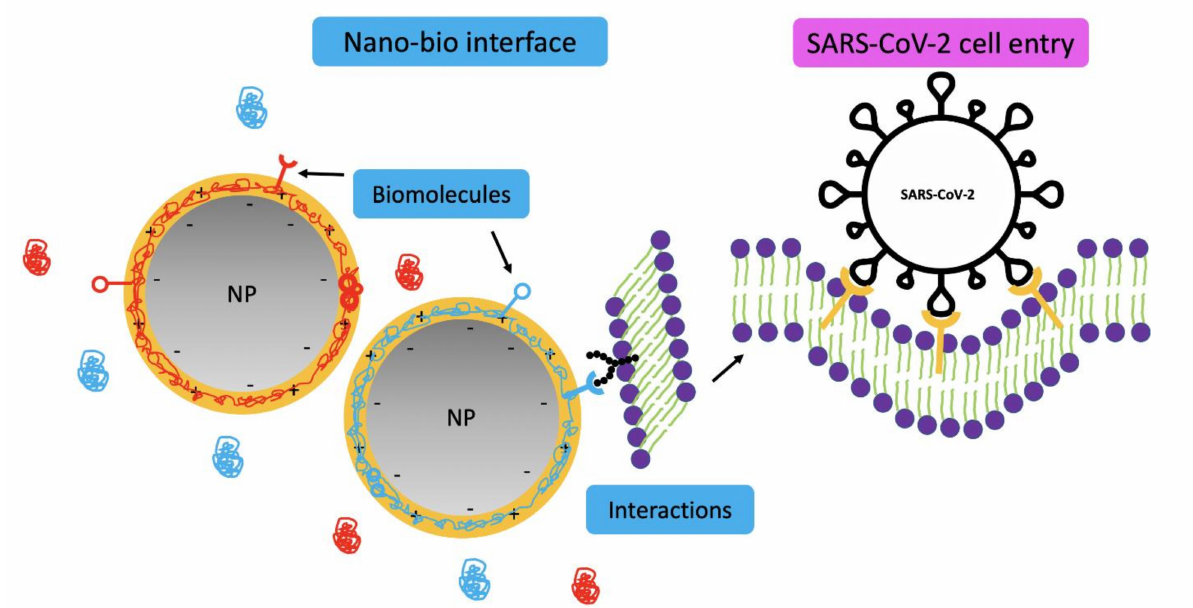
Figure 2. Interactions and forces between nanoparticles (NPs) and biological interfaces (i.e., protein corona, PC) with an accompanying illustration of cellular endocytosis of SARS-CoV-2, which is also spherical and falls within the nanometer range. Interactions and forces that occur at the contact of NPs with cells or upon suspension in biological media include biomolecular interactions, repulsive electrostatic forces, attractive Van der Waals and depletion forces, and covalent forces